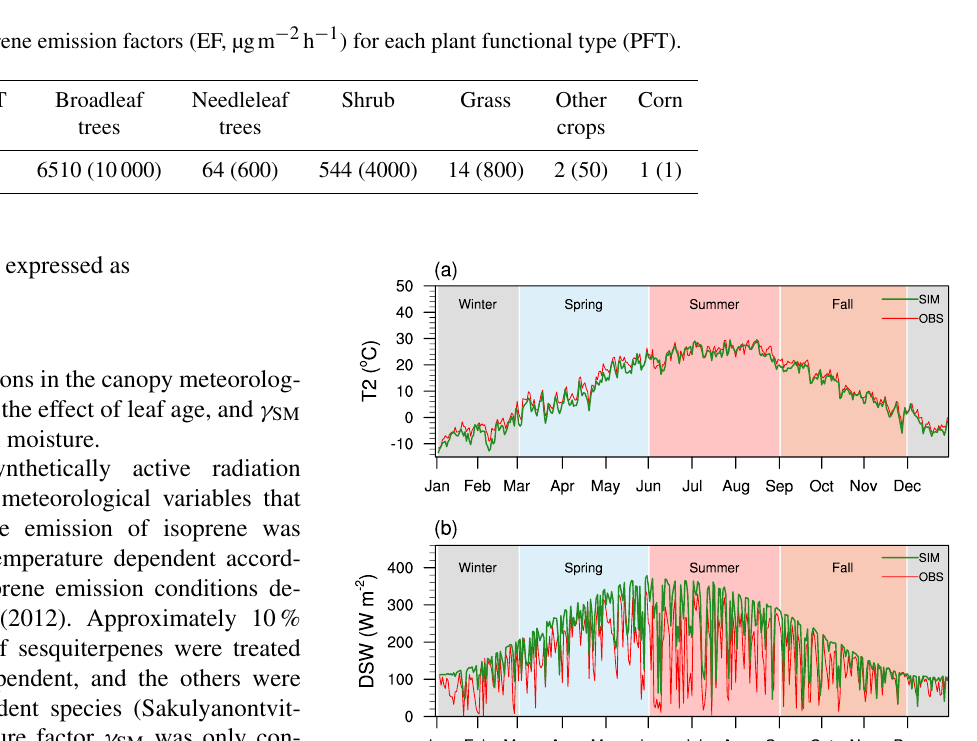
Figure 1. Time series plots of (a) station-averaged simulated and in situ 2m temperature (T2) as well as (b) simulated and in situ downward shortwave radiation (DSW) at the Beijing